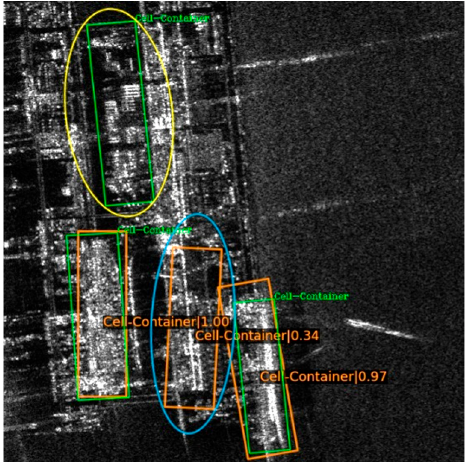
Figure 1. Detection results of the common method. The green boxes, orange boxes, yellow ellipses, and blue ellipses represent the ground truth, detection objects, missing ships, and false alarms, re- spectively.